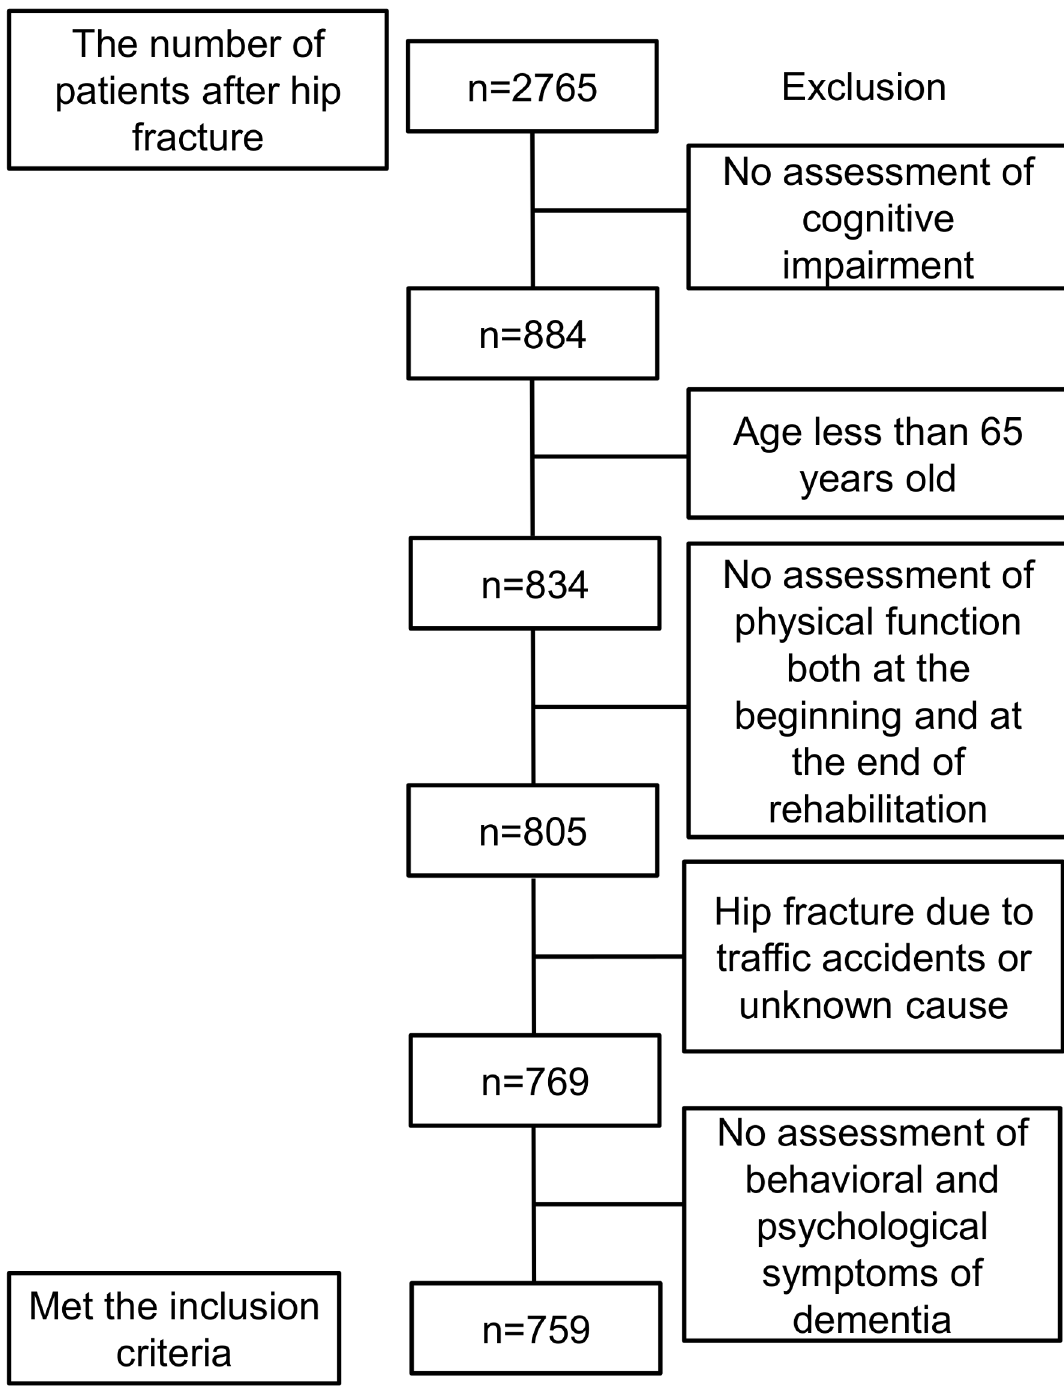
Fig 1. Flow chart of eligibility for the database after hip